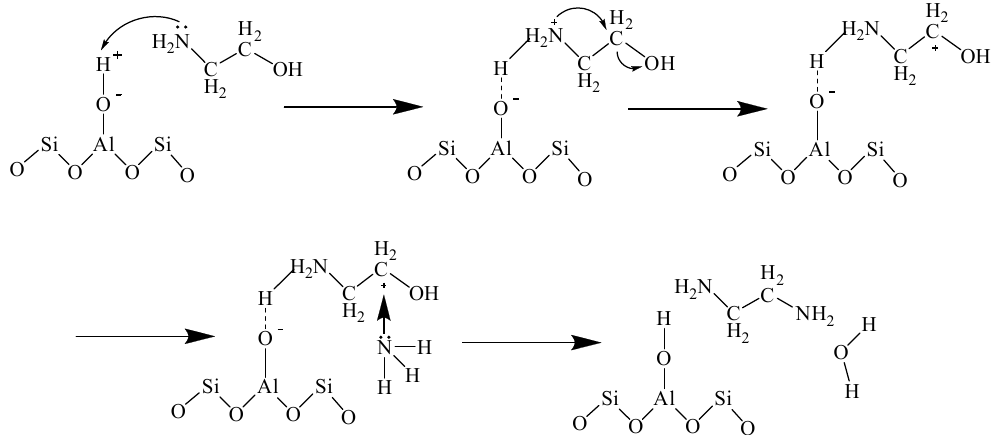
Figure 10. Adsorption model of NH 3 and different groups of MEA over H-MOR. ( a ) MEA–N–H–MOR